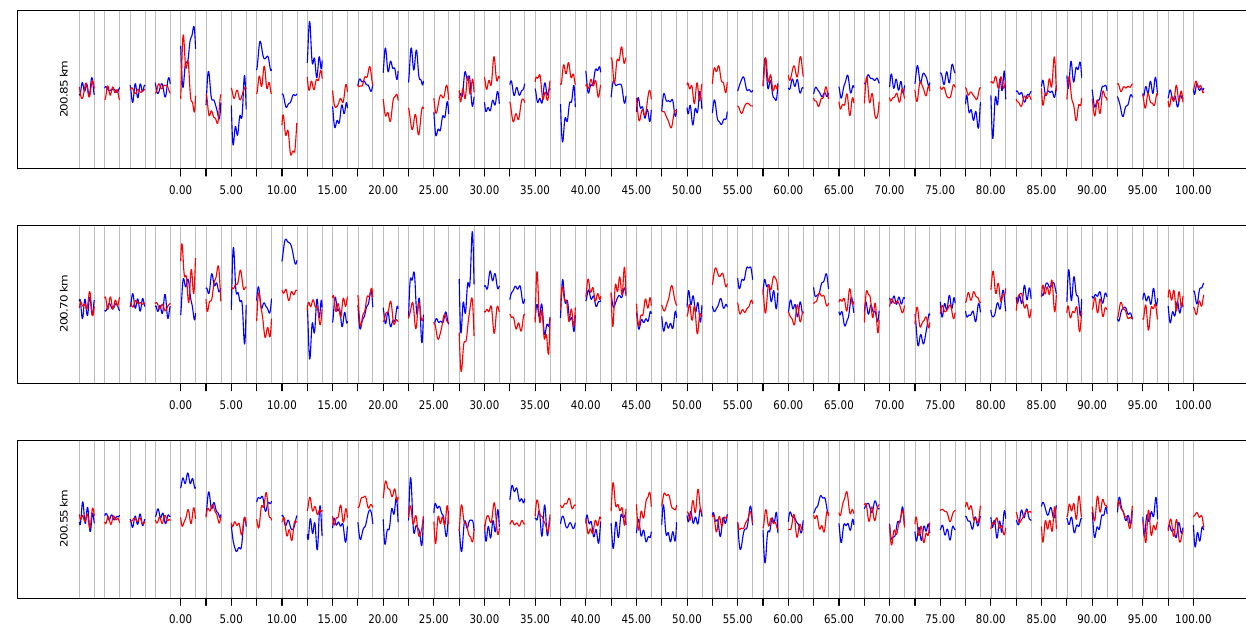
Fig. 5. Estimated backscatter amplitude from three ranges during the first 100ms of heating. The estimate is based on the statistically most probable value of parameter vector θ given the measurements. The red and blue lines represent the real and complex parts of the baseband signal in linear scale. This F-region heating event is the same as the one in Fig. 4. The amplitude is modelled for 150 µ s, which is the time that the transmission pulse travels through the range gate. Discontinuities in the figure are greater than they appear in, they are determined by the inter-pulse period, which is approximately 2.5ms in this